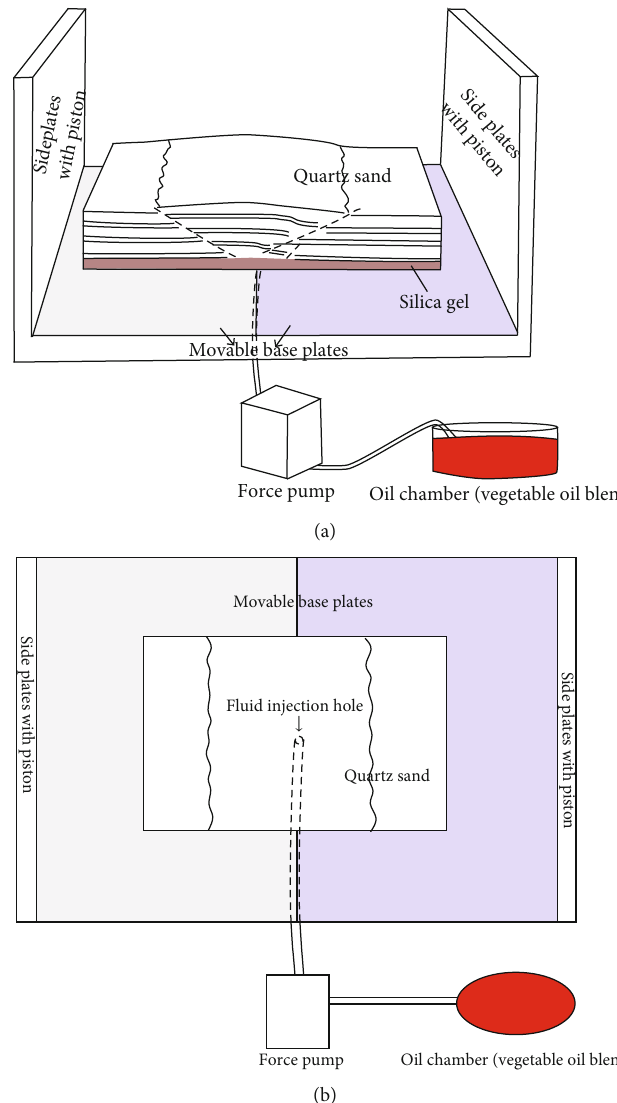
Figure 3: A typical sandbox simulation experiment device: (a) stereogram of the device; (b) plane fi gure of the experiment